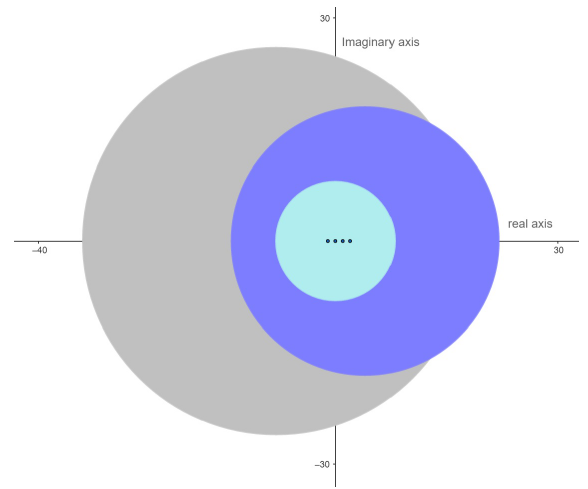
Figure 4: The Gershgorin region of A T is in gray, the Gershgorin region of the second type of C T is in blue and the Gershgorin region of the second type of F T is in turquoise. The four small points represent the eigenvalues of A